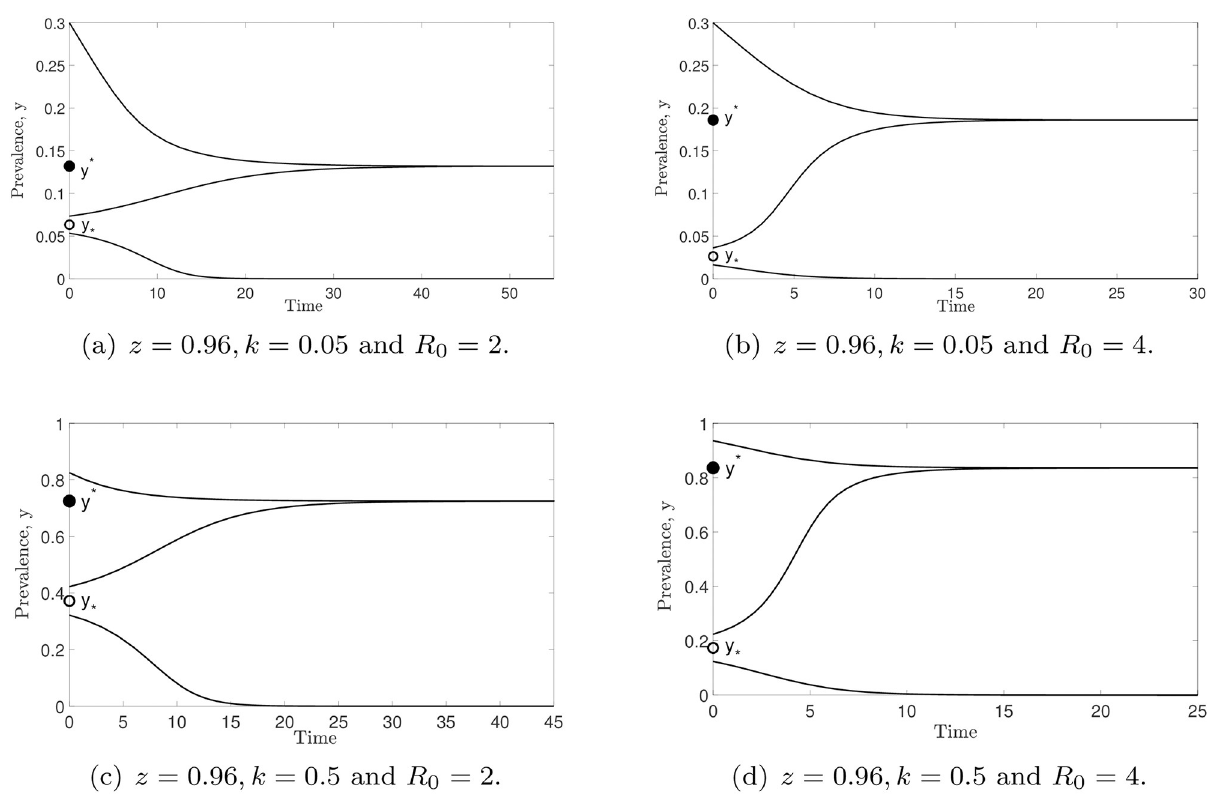
Fig 4. The dynamics of model (5) when varying k , R 0 and initial value y 0 . By varying k and R 0 values, all solutions of this model converge to zero if y 0 < y � , whereas the solutions of this model approach the endemic equilibrium y � whenever y 0 > y � as t ! 1 .